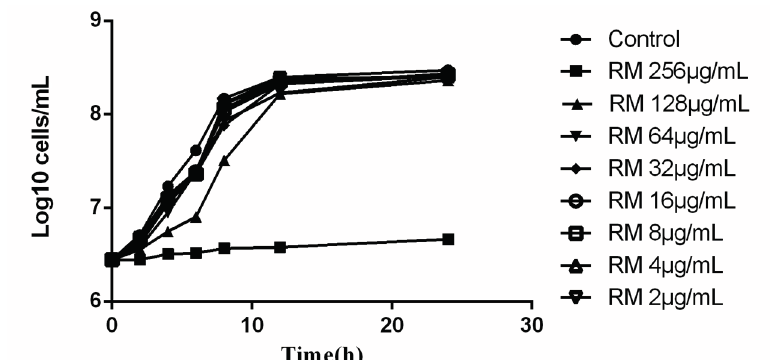
Figure 2. Effects of different concentrations of RM on fungal growth of C. albican